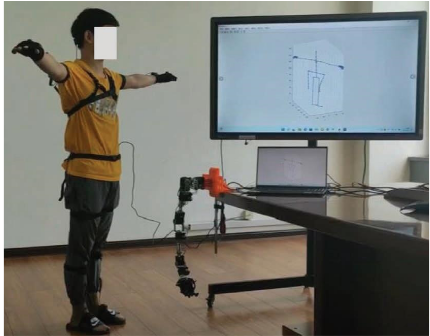
Figure 12: Overall diagram of the test system.